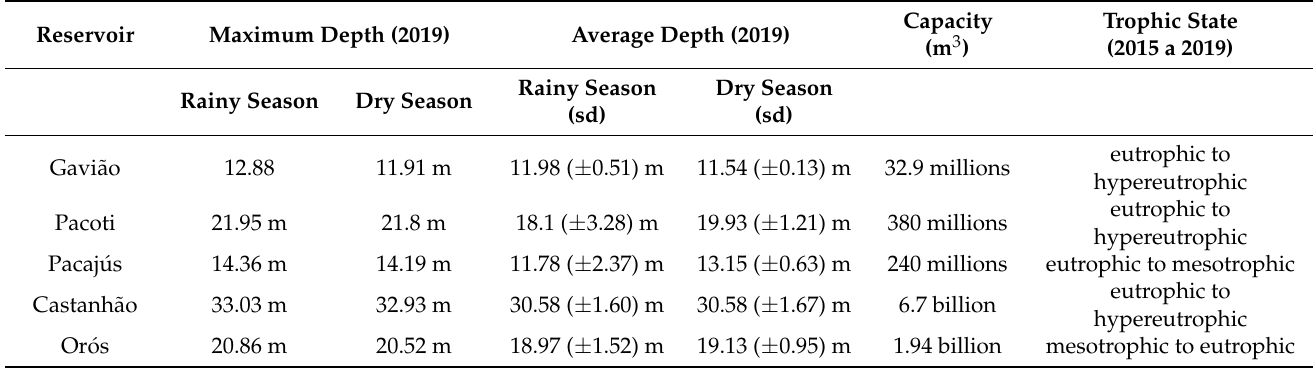
Table 1. Reservoir studied (capacity = maximum water volume; average depth combined with standard deviation—sd). Source: Portal Hidrol ó gico do Cear á